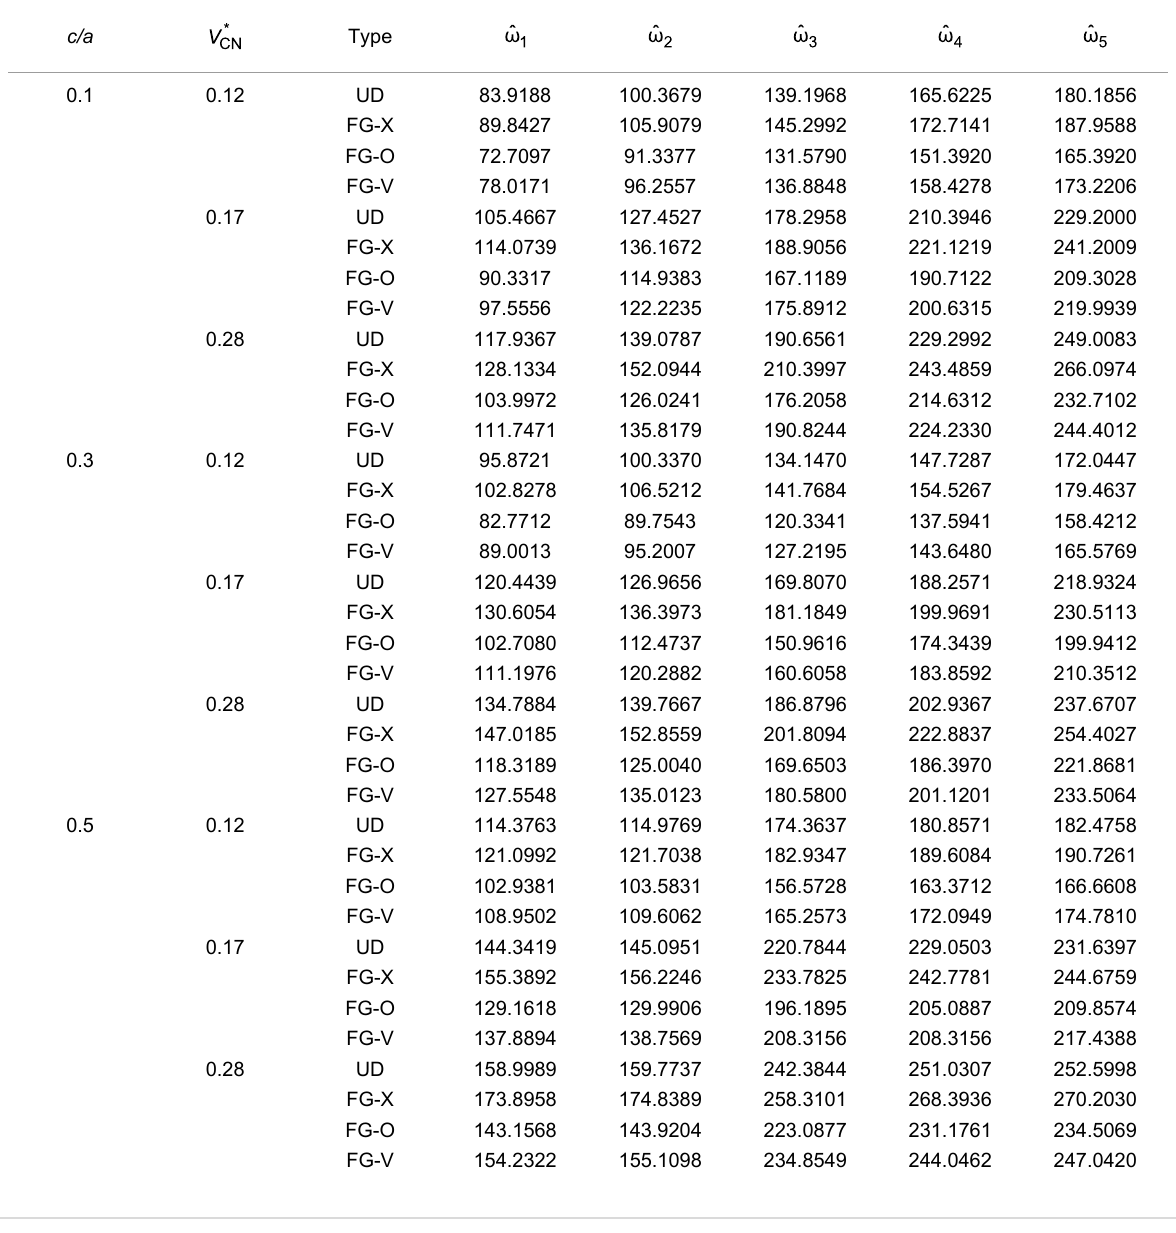
Table 12: First five natural frequency parameters for square, FG-CNTRC, CCCC plates with a centric cutout. The geometrical characteristics of the plate are a/b = 1, h/a = 0.05 and c/a = 0.5. c/a Type